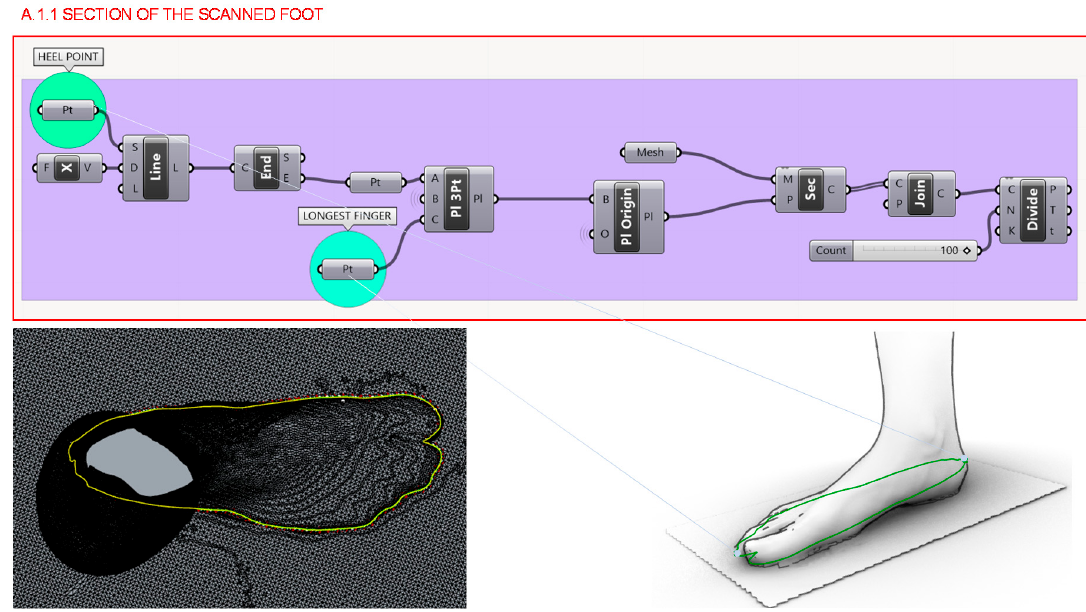
Figure 6. Programming structure definition to generate the section of the scanned foot model.